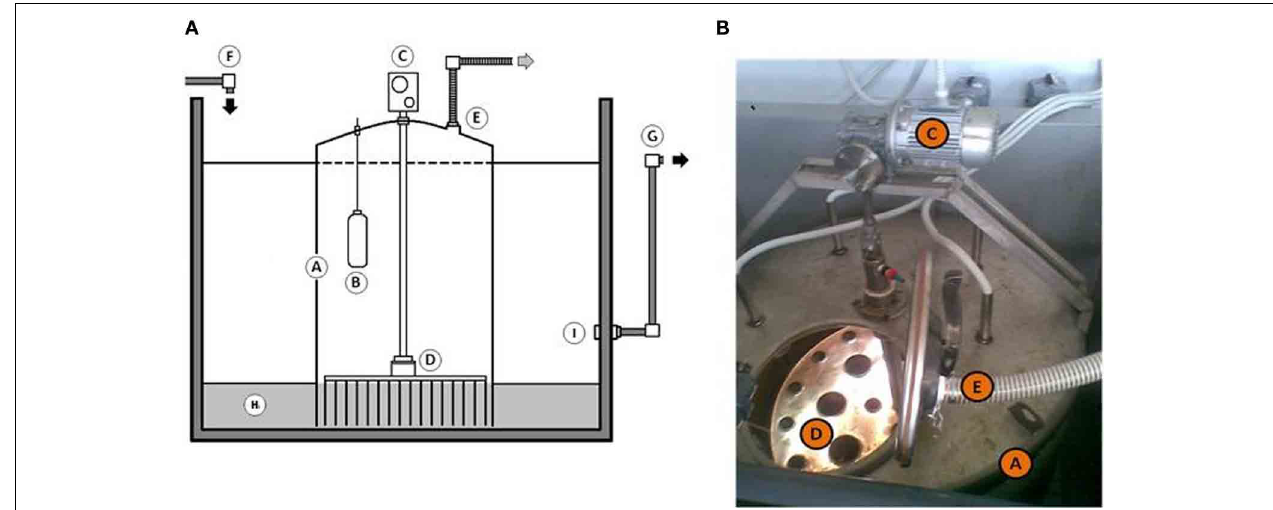
FIGURE 1 | (A,B) Schematic representation (A) and detail (B) of “Modular Slurry System” used throughout this study. Abbreviation used: A, Modular Slurry System; B, temperature controller; C, external air pump;